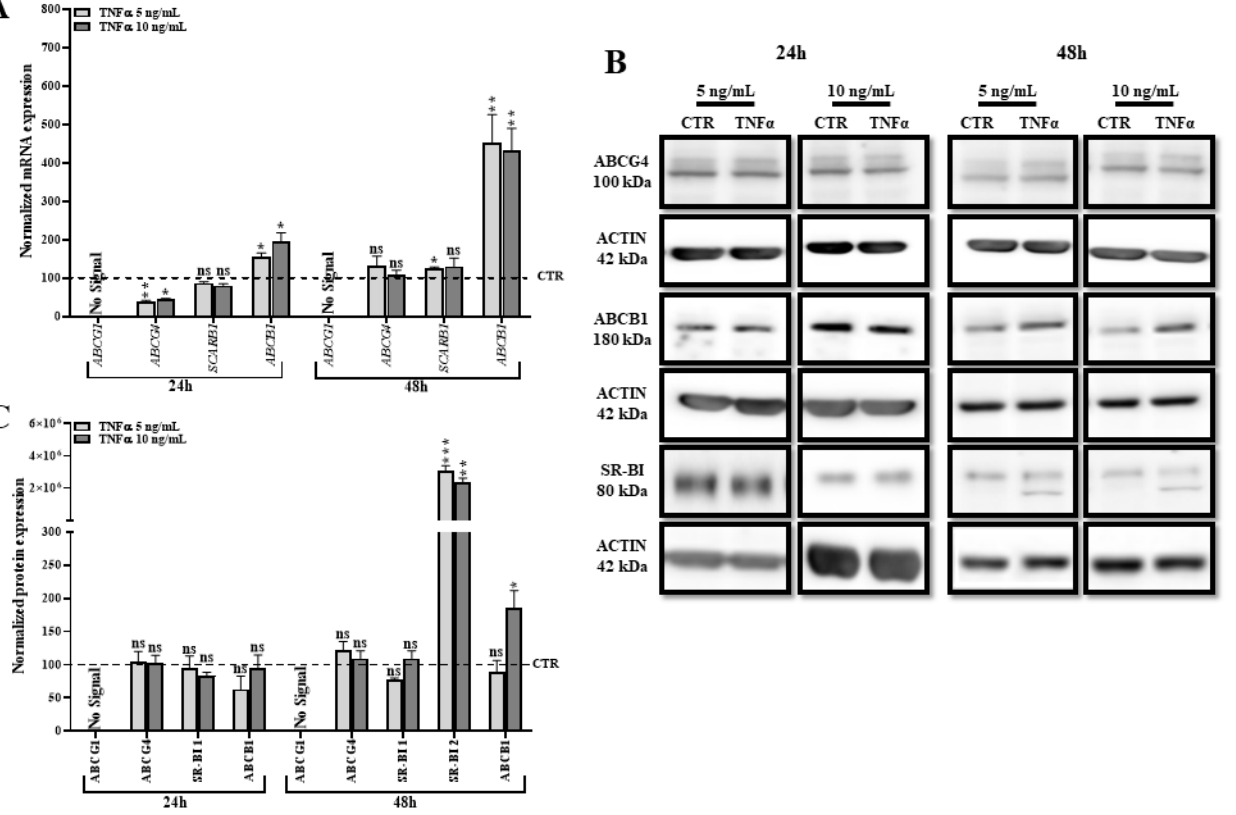
Figure 7. TNFα increases expression of other transporters involved in lipid release. ( A ) Transcrip- tional expression of ABCG1 , ABCG4 , SCARB1 , and ABCB1 mRNAs was monitored by RT-qPCR. Each bar represents the level of mRNA normalized to the housekeeping gene GAPDH , relative to the control condition (CTR). Data are shown as the mean ± SEM of three experiments from pooled triplicates (N = 3). ( B ) ABCG4 , ABCB1 and SR-BI protein levels assessed by Western blot. ( C ) Each bar represents the level of quantified protein signal normalized to ACTIN, relative to the CTR condition. Data are shown as the mean ± SEM of three independent experiments (N = 3). Statistical analysis